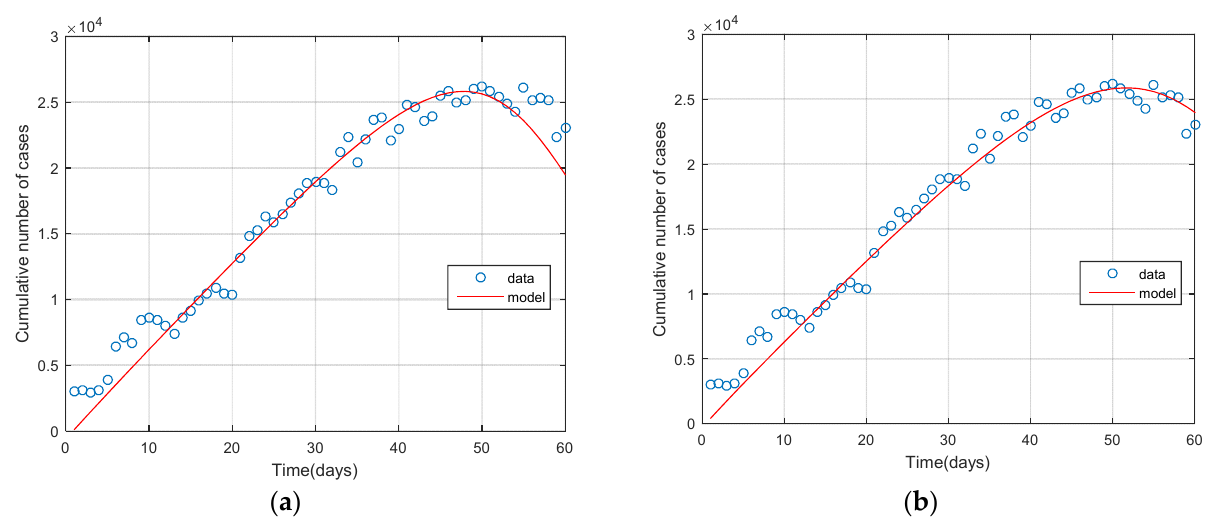
Figure 2. Data fitting of the model (3)–(12) to the actual data: ( a ) susceptible with vaccinated fitting; ( b ) susceptible with unvaccinated fitting.